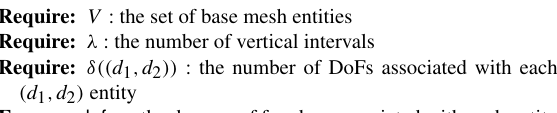
Algorithm 1 Computing the global numbering for degrees of freedom on an extruded mesh